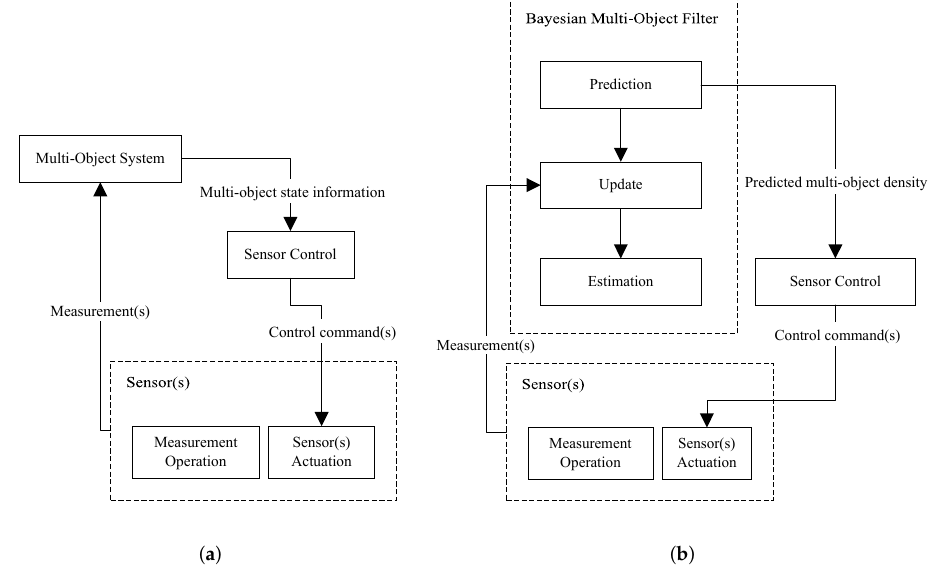
Figure 1. ( a ) general block diagram of a multi-object system with sensor control; ( b ) common data flow with a Bayesian multi-object filter used to implement the multi-object system.